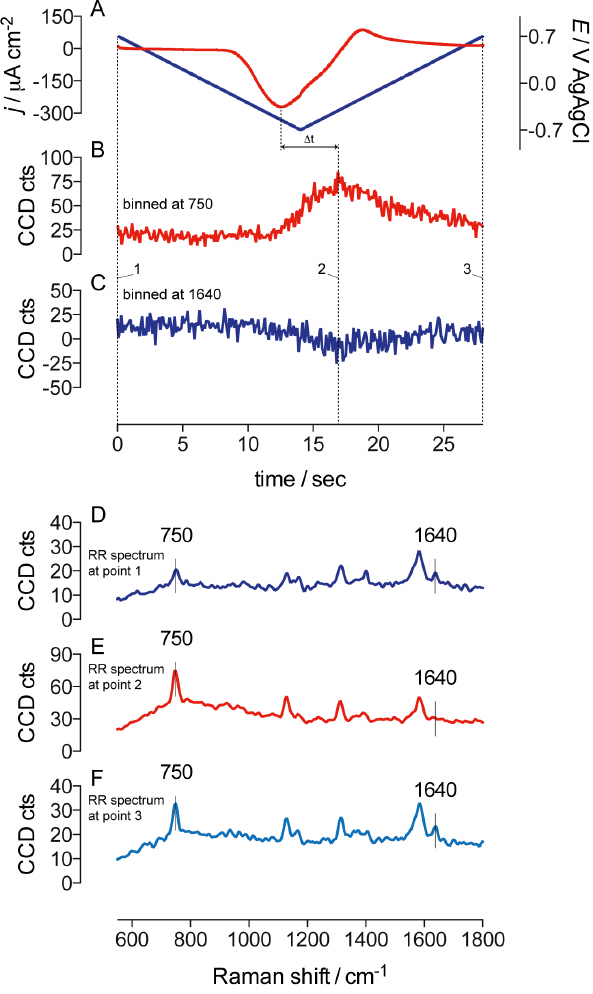
Figure 4. Example of combined voltammetry and RR measure- ments performed on a mature biofilm in acetate-depleted medium. RR spectra were collected continuously from a fixed portion of the biofilm positioned at approximately 50 m m from the electrode surface. A) current/potential vs. time (scan rate: 100 mV s 2 1 ). B) time- series of the intensity of the RR spectra binned for the marker mode n 15 at 750 cm 2 1 , and C) the marker mode n 10 at 1640 cm 2 1 . D) RR spectra collected at time point 1 (0 s). E) RR spectra collected at time point 2 (17 s). F) RR spectra collected at time point 3 (28 s).